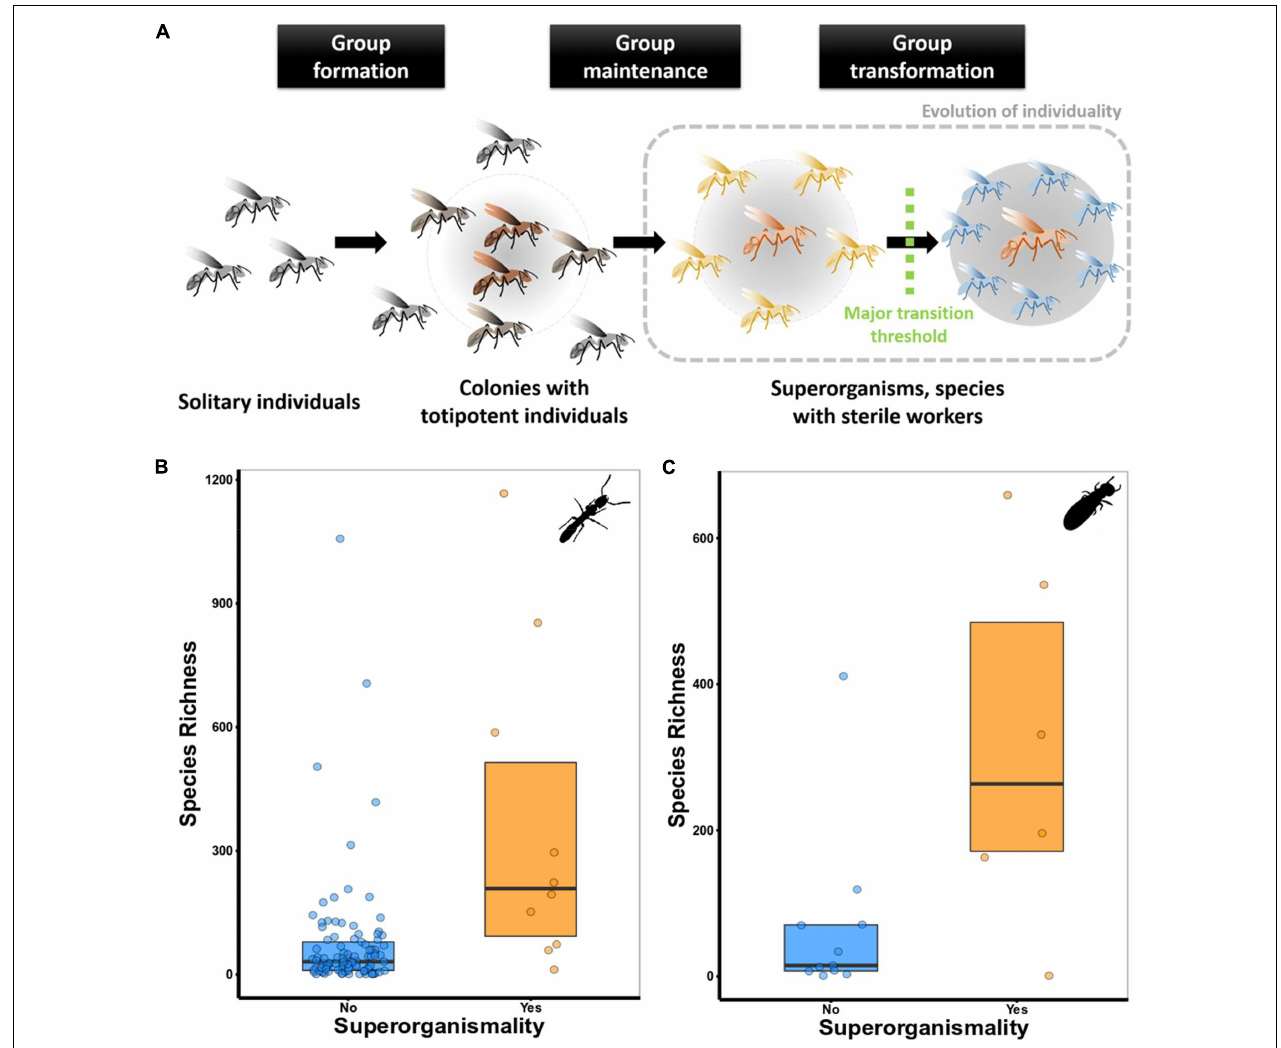
FIGURE 1 | (A) The three key steps that characterise a major evolutionary transition (following Bourke, 2011, 2019). These steps go along with important changes in terms of cooperation and conflict within groups (see main text for details). (B) Species richness in superorganismal and non-superorganismal ant genera. Species richness was significantly higher in superorganismal than non-superorganismal ant genera (Mann–Whitney U test: N = 337, W = 355, P < 0.005). Controlling for phylogenetic dependencies, a phylogenetic ANOVA was run on a subset of 111 genera for which a phylogeny was available. They showed that genera with sterile workers ( N = 10) had higher species richness than genera that we do not consider superorganismal ( F = 24.56, P ≤ 0.005) (see Supplementary Material for more details). (C) Species richness in superorganismal and non-superorganismal termite lineages. There was a trend for species richness to be significantly higher